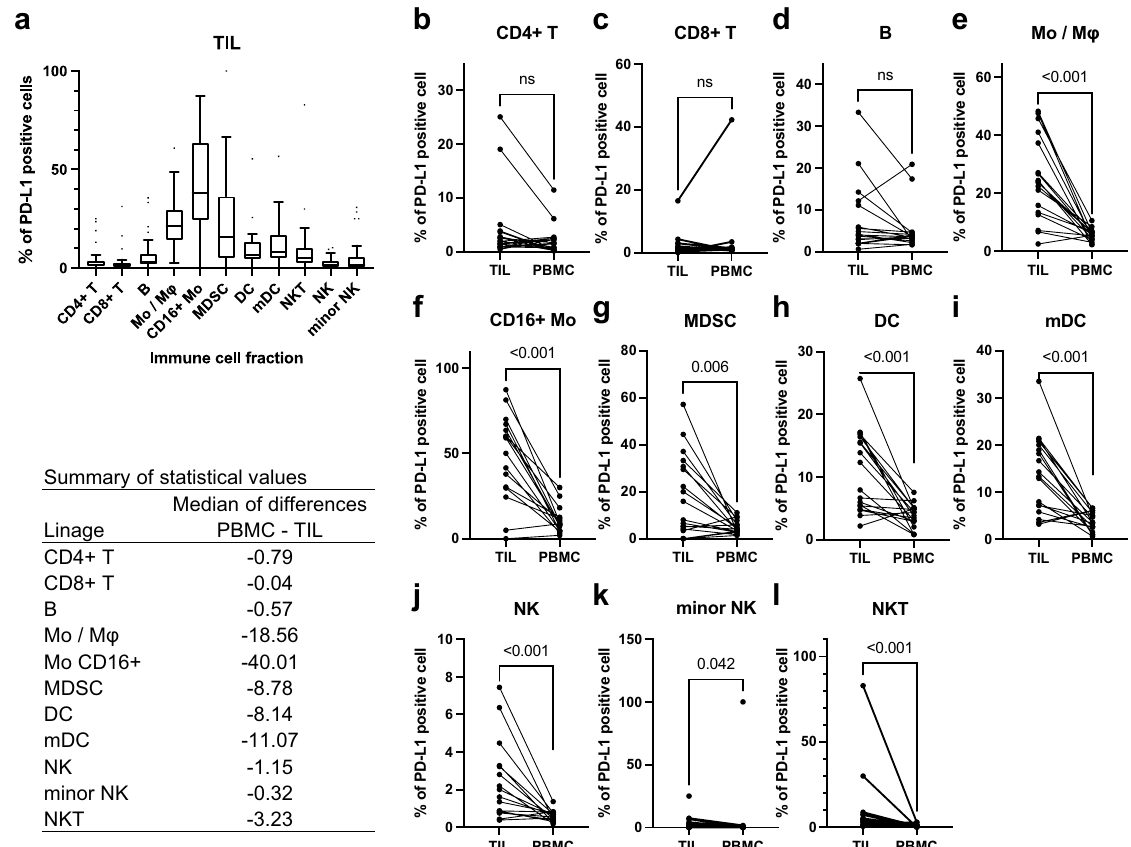
Figure 3. PD-L1 is preferentially expressed in part of the immune cell fraction, and its expression is higher in tumor-infiltrating leukocytes than in blood. The percentages of PD-L1-positive cells of each immune cell fraction were determined in tumor tissues (TIL) and blood (PBMC). ( a ) The percentages of PD-L1-positive cells in each immune cell fraction present in tumor tissue are shown in Tukey box plots. ( b – l ) For the cases with matched samples of blood and tumor tissue, the percentages of PD-L1-positive cells of each immune cell fraction were compared in tumor tissue (TIL) and blood (PBMC) using the Wilcoxon test. Values of P < 0.05 are considered statistically significant. The actual P -values are shown in the graphs. The medians of the differences are summarized in the table on the left side of the